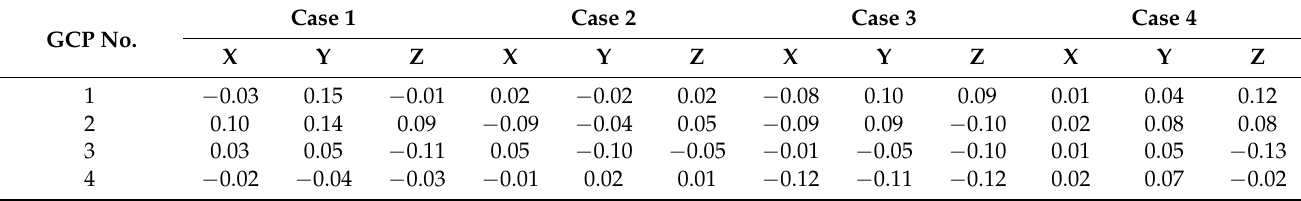
Table 6. Checkpoint errors for horizontal (x, y) and vertical (z) for orthophotos for each case at 50 m (unit: